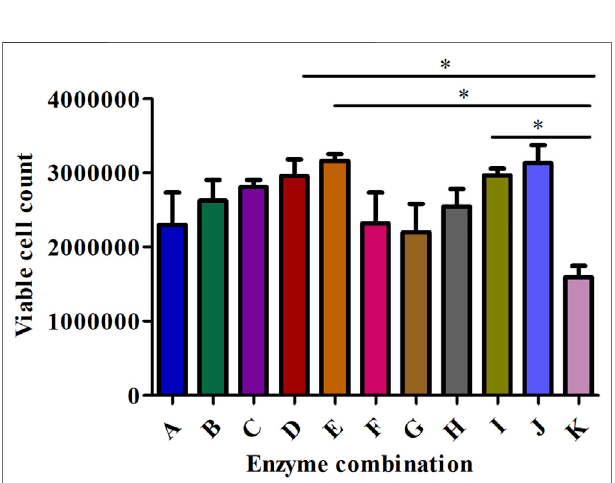
FIGURE 4 | The effect of different enzyme combinations on cell count during kidney tissue digestion. Data are presented as means ± SD; * p value = 0.0129.